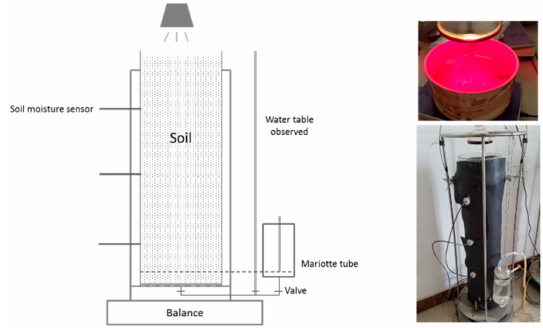
Figure 1. Diagram of the